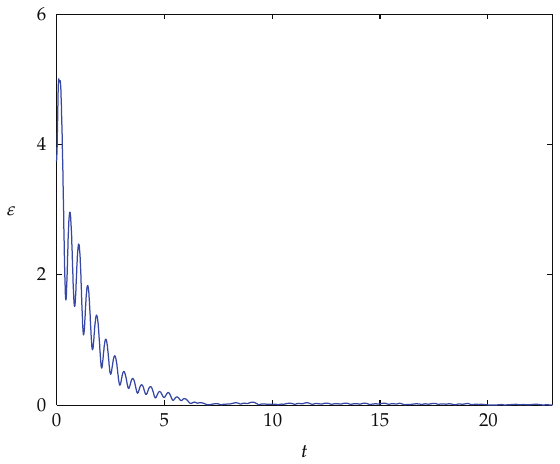
Figure 2: The HPS result between the drive system (cid:4) 3.1 (cid:5) and its response system (cid:4) 3.2 (cid:5) for q (cid:7) 0 .